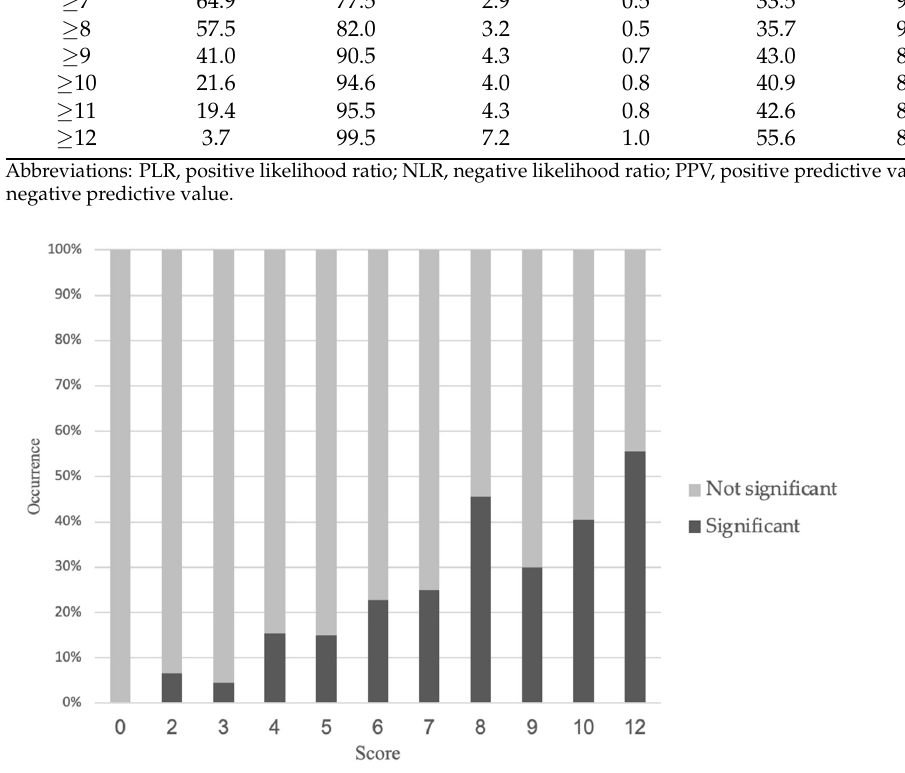
Figure 2. Observed occurrence of significant stenosis according to the new score.